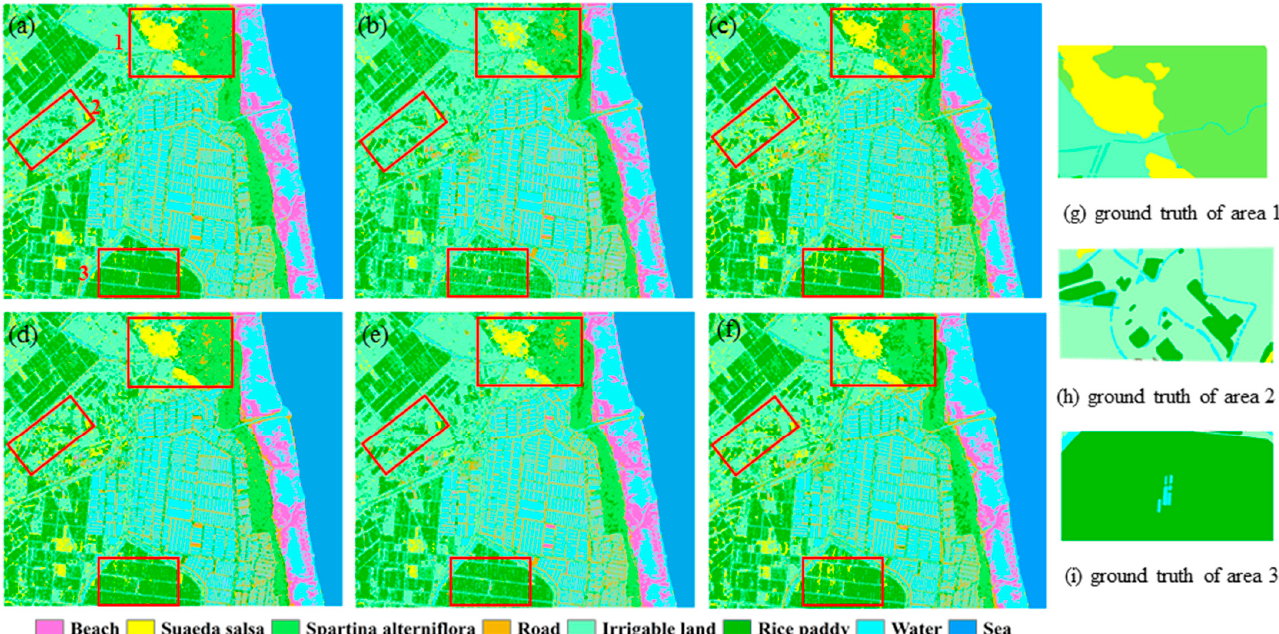
Figure 7. Classification result using different feature sets: ( a ) FS with random forest; ( b ) H/A /span with random forest; ( c ) Neu_tua/Neu_pha/span with random forest; ( d ) Y4 with random forest; ( e ) ALL with random forest; ( f ) ALL with SVM; ( g ) ground truth of area 1; ( h ) ground truth of area 2; and ( i ) ground truth of area 3. Table 3. Accuracy of the different feature sets.